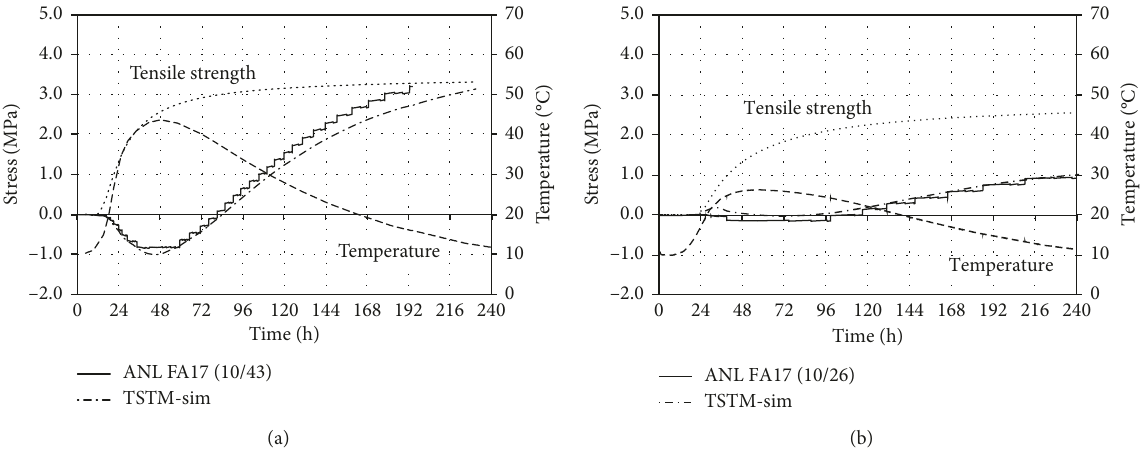
Figure 7: Stress development winter conditions: ANL FA17 (a) and ANL FA45 (b). –2.0–1.00.01.02.03.04.05.0